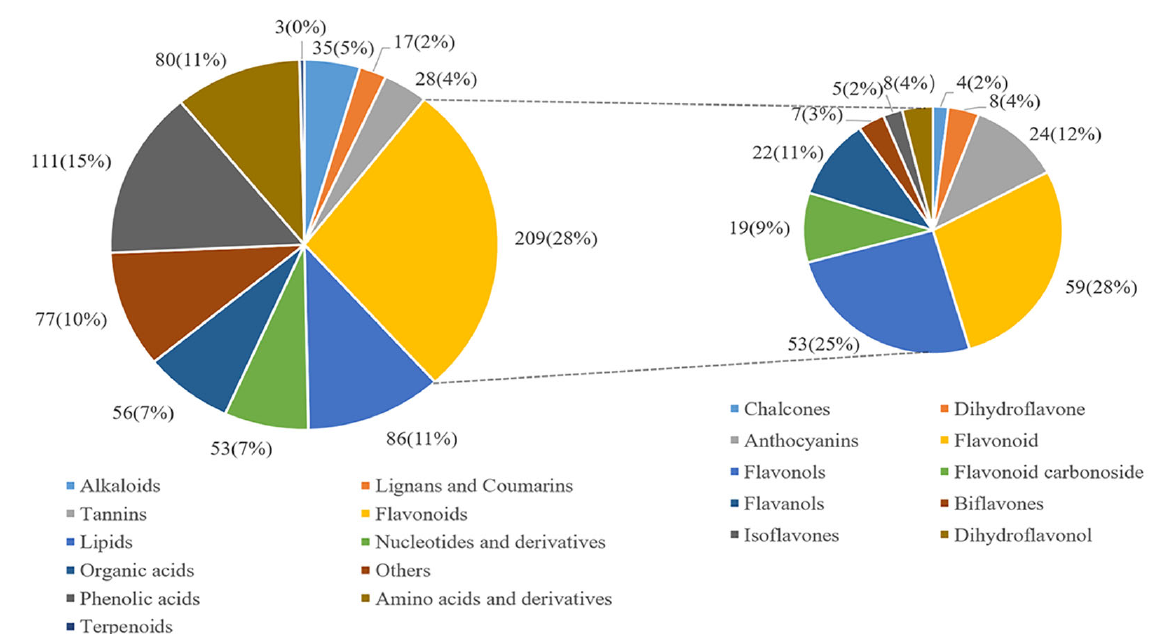
Figure 3. Classification of metabolites identified in Changqing tea shoots. For different season comparisons, 49, 127, 94, 112, 61, and 49 differential metabolites were identified in L vs. XL, N vs. XN, L vs. QL, N vs. QN, XL vs. QL, and XN vs. QN, respectively (Figure 4A and Table S2). For differential metabolites, flavonoids, phenolic acids, and amino acids and derivatives accounted for the largest number, which were the most important constituents of tea flavor (Figure 4B). Furthermore, the difference of